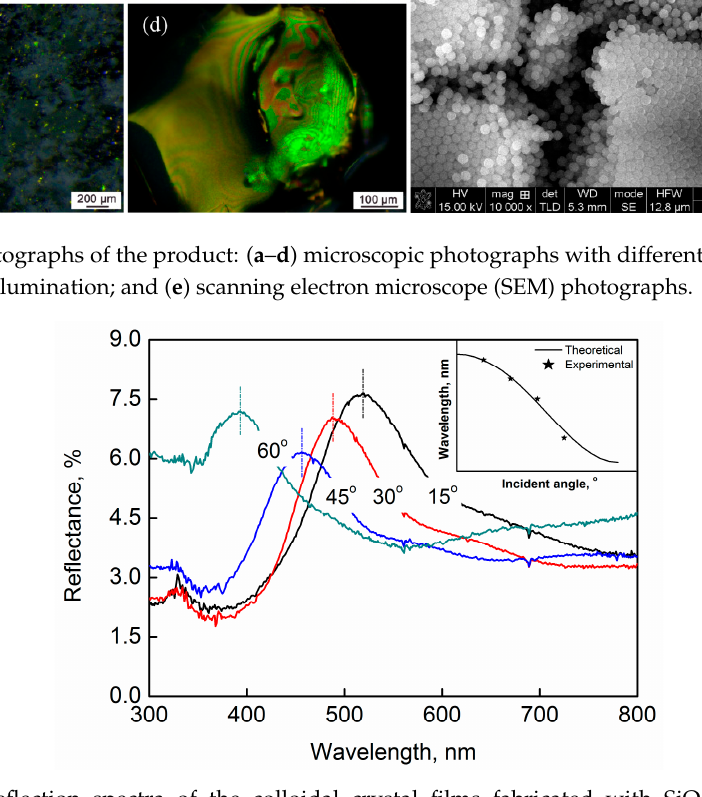
Figure 3. Reflection spectra of the colloidal crystal films fabricated with SiO 2 nanoparticles (with diameters about 240 nm) with different incident angles.